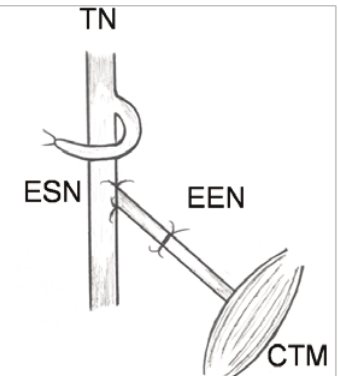
FIGURE 3 – Group 1 (one-stage) and second surgery of group 2 (two-stage). TN : tibial nerve. ESN : end-to-side neurorrhaphy. EEN : end-to-end neurorrhaphy. CTM : cranial tibial